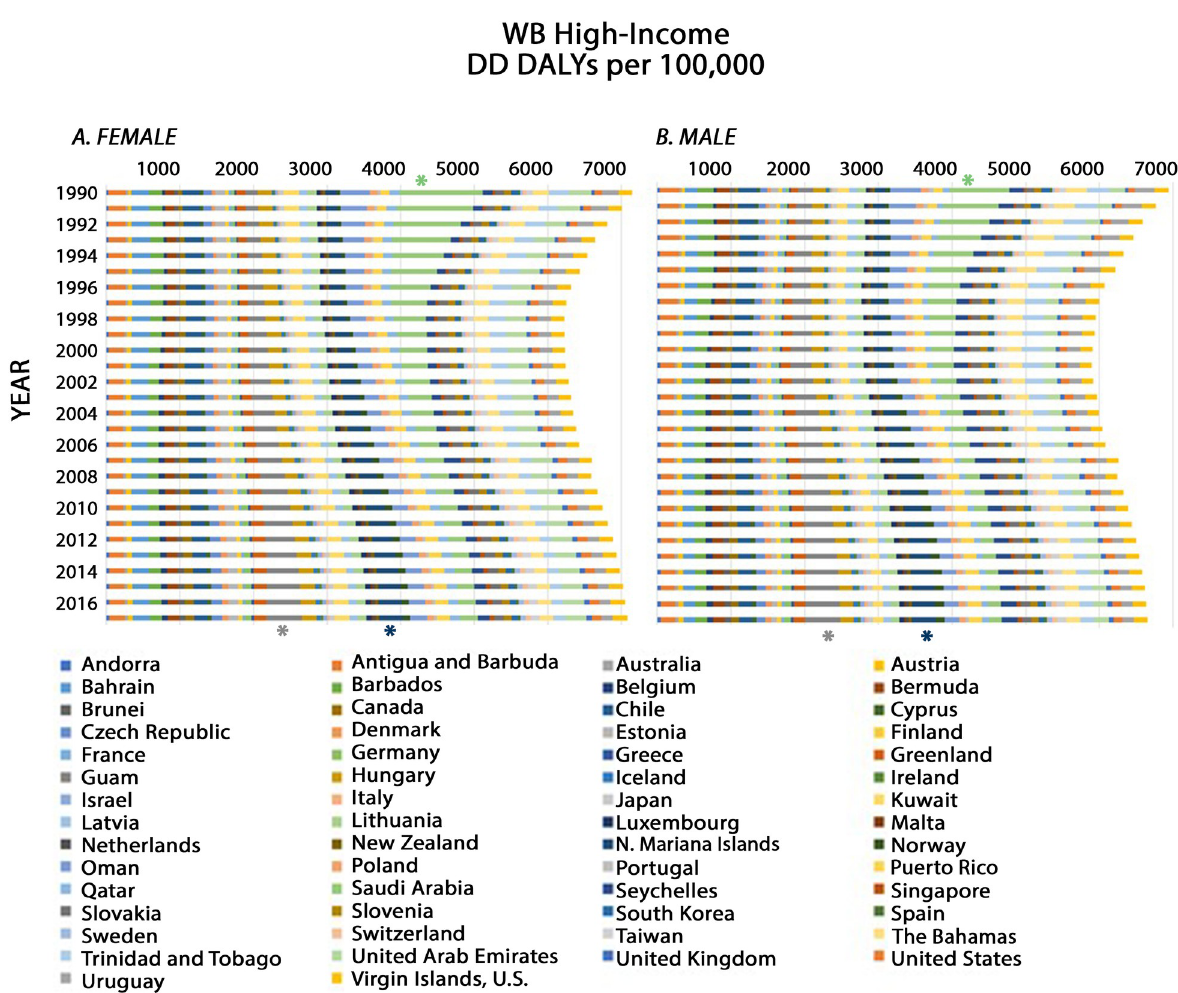
Fig 5. Age-standardized DD DALY rates from 1990 to 2017 in WB high-income constituents for females (A) and males (B). For each year (bar), the DD DALY rate per 100,000 represents the sum of individual country DD DALY rates given in alphabetical order from left to right as